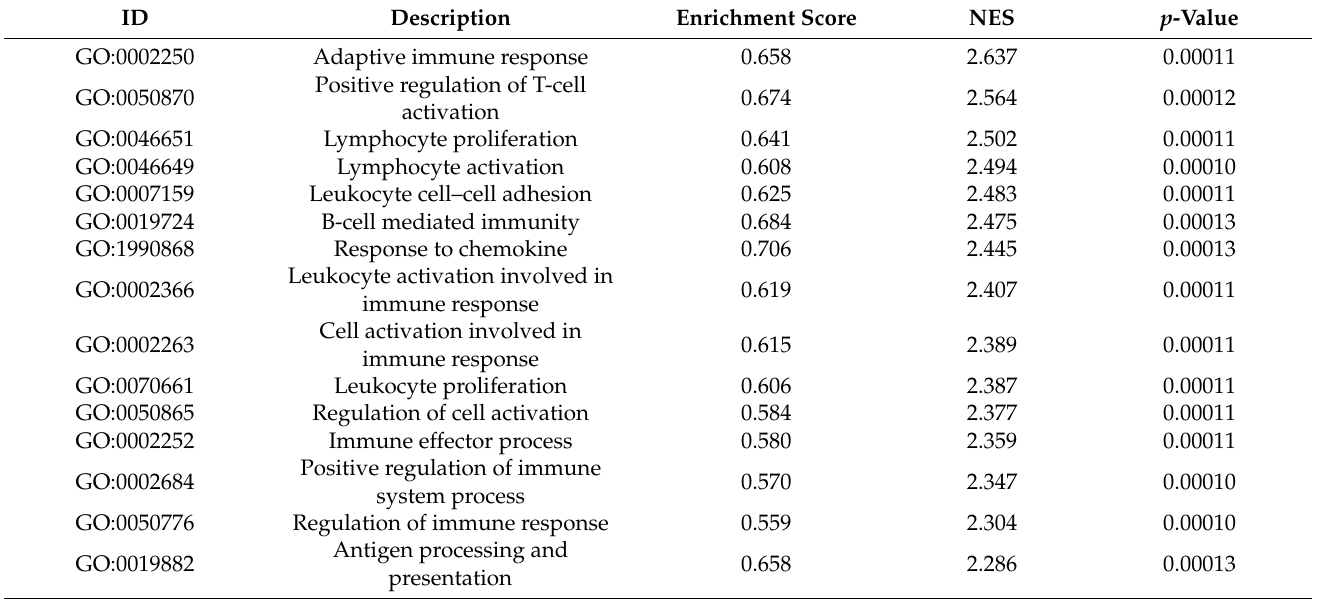
Figure 4. Gene Set Enrichment Analysis (GSEA) plots of BP terms enriched in HT samples. ( A ) Bubble plot of BP terms, ( B ) Emapplot, ( C ) Cnetplot, and ( D ) Ridgeplot with ranked DEGs of the HT group from microarray data. ( E ) GSEA BP plot with ranked DEGs of the HT group from microarray data. All plots were created by using clusterprofiler R package. Table 2. Top 15 BP terms from GSEA of Hashimoto’s thyroiditis samples, ranked by Normalized Enrichment Score